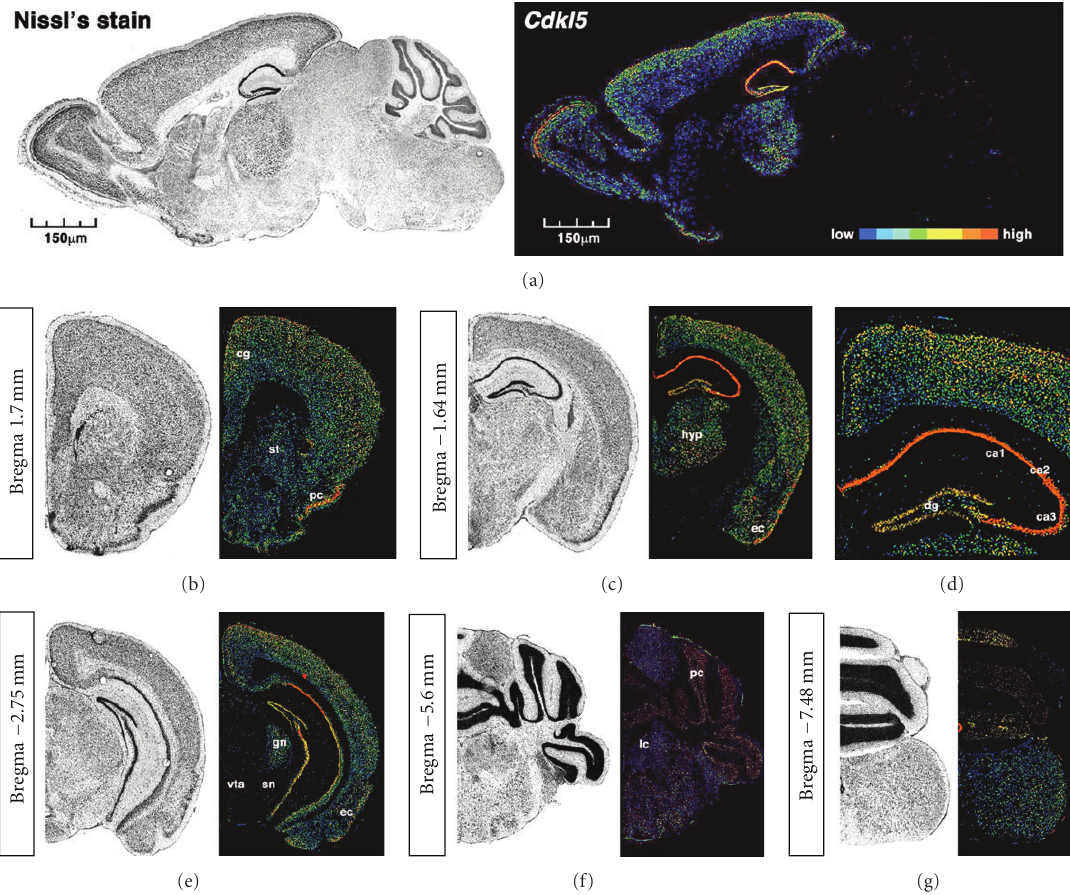
Figure 3: Cdkl5 expression patterning in the adult male mouse brain (C57BL/6J, postnatal day 56). Images are collected from the Allen Brain Atlas website (http://www.brain-map.org/; probe name RP 051219 02 C01; experiment ID 74000486 for sagittal samples, experiment ID 75042239 for coronal samples). Each Nissl-stained section is coupled by a quantitative in situ hybridization screening at di ff erent sectioning levels. The color bar in (a) might be used to follow transcription level intensity. (b), (c), (d), (e), (f), and (g) are representative of di ff erent brain levels, therefore, di ff erent brain areas; in particular: cg: cingulated cortex, st: striatum, pc: piriform cortex, hyp: hypothalamus, ec: entorhinal cortex, dg: dentate gyrus, ca1,2,3: hippocampal CA fields, vta: ventral tegmental area, gn: geniculate nuclei, sn: substantia nigra, lc: locus ceruleus, pc: Purkinje